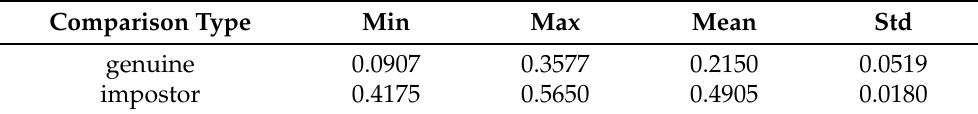
Table 5. Matching distance statistics for the combined dataset.